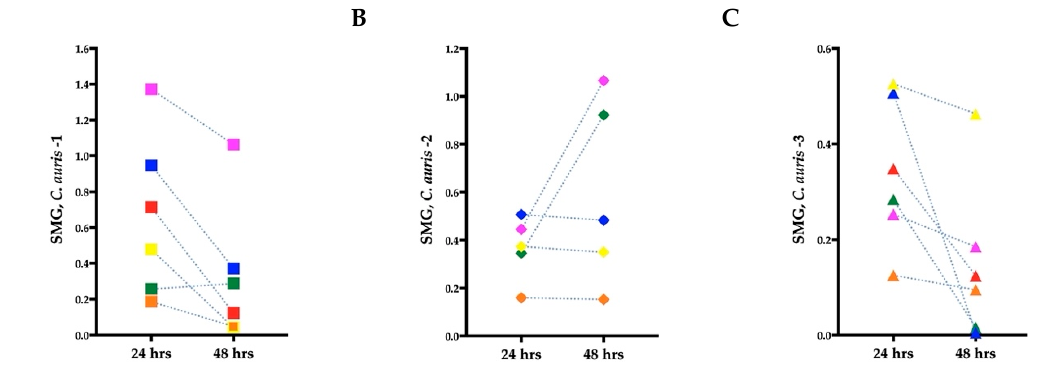
Figure 6. Supra-MIC growth (SMG) of C. auris isolates 1 to 5 ( A – E ) for adjuvant antifungal broth microdilution assays. Chloroquine did not show any adjuvant effect on C. auris isolate 1 when combined with itraconazole, nor for C. auris isolate 2 when combined with itraconazole or voriconazole at 48 h compared to 24 h. Similarly, no adjuvant effect was noted for C. auris isolate 4 against fluconazole nor for C. auris isolate 5 against posaconazole and amphotericin B. Since C. auris isolate 2 is resistant to fluconazole and C. auris isolate 5 is resistant to fluconazole and caspofungin, the SMGs were not calculated for these isolate–adjuvant–antifungal combinations.